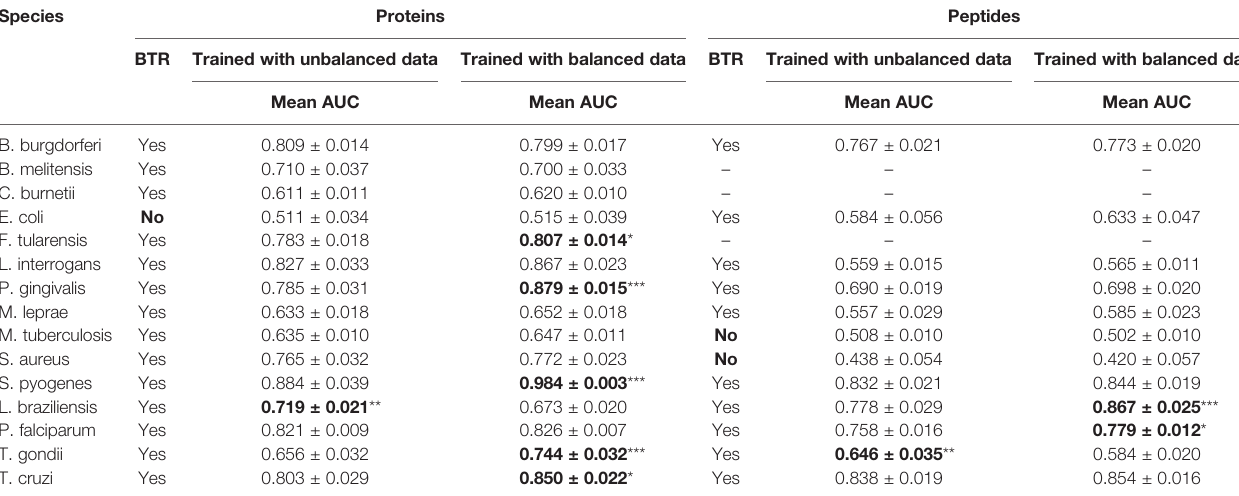
TABLE 4 | Prediction results for the speci fi c models.